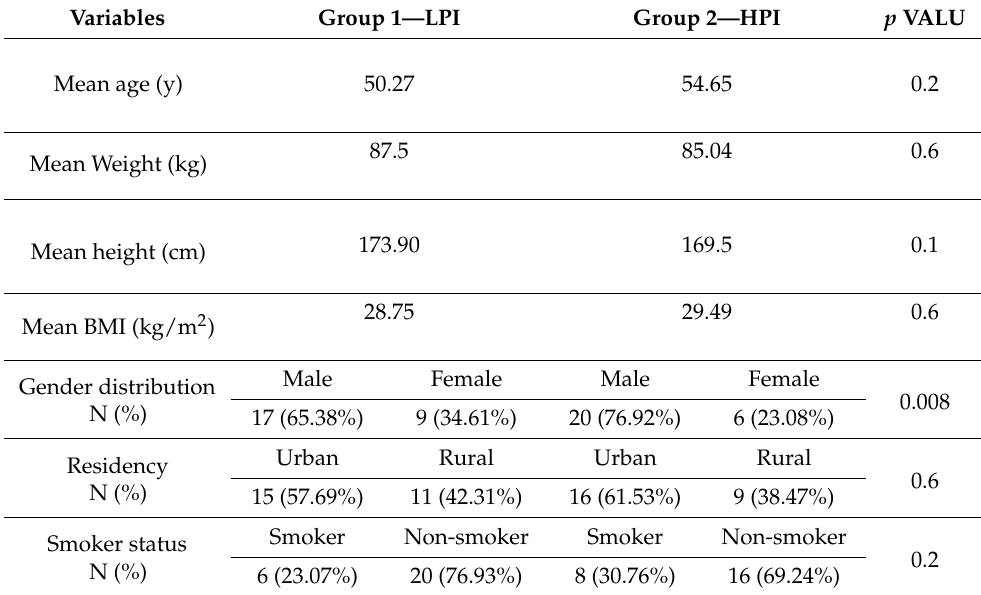
Table 2. Demographic and risk factors data of the study